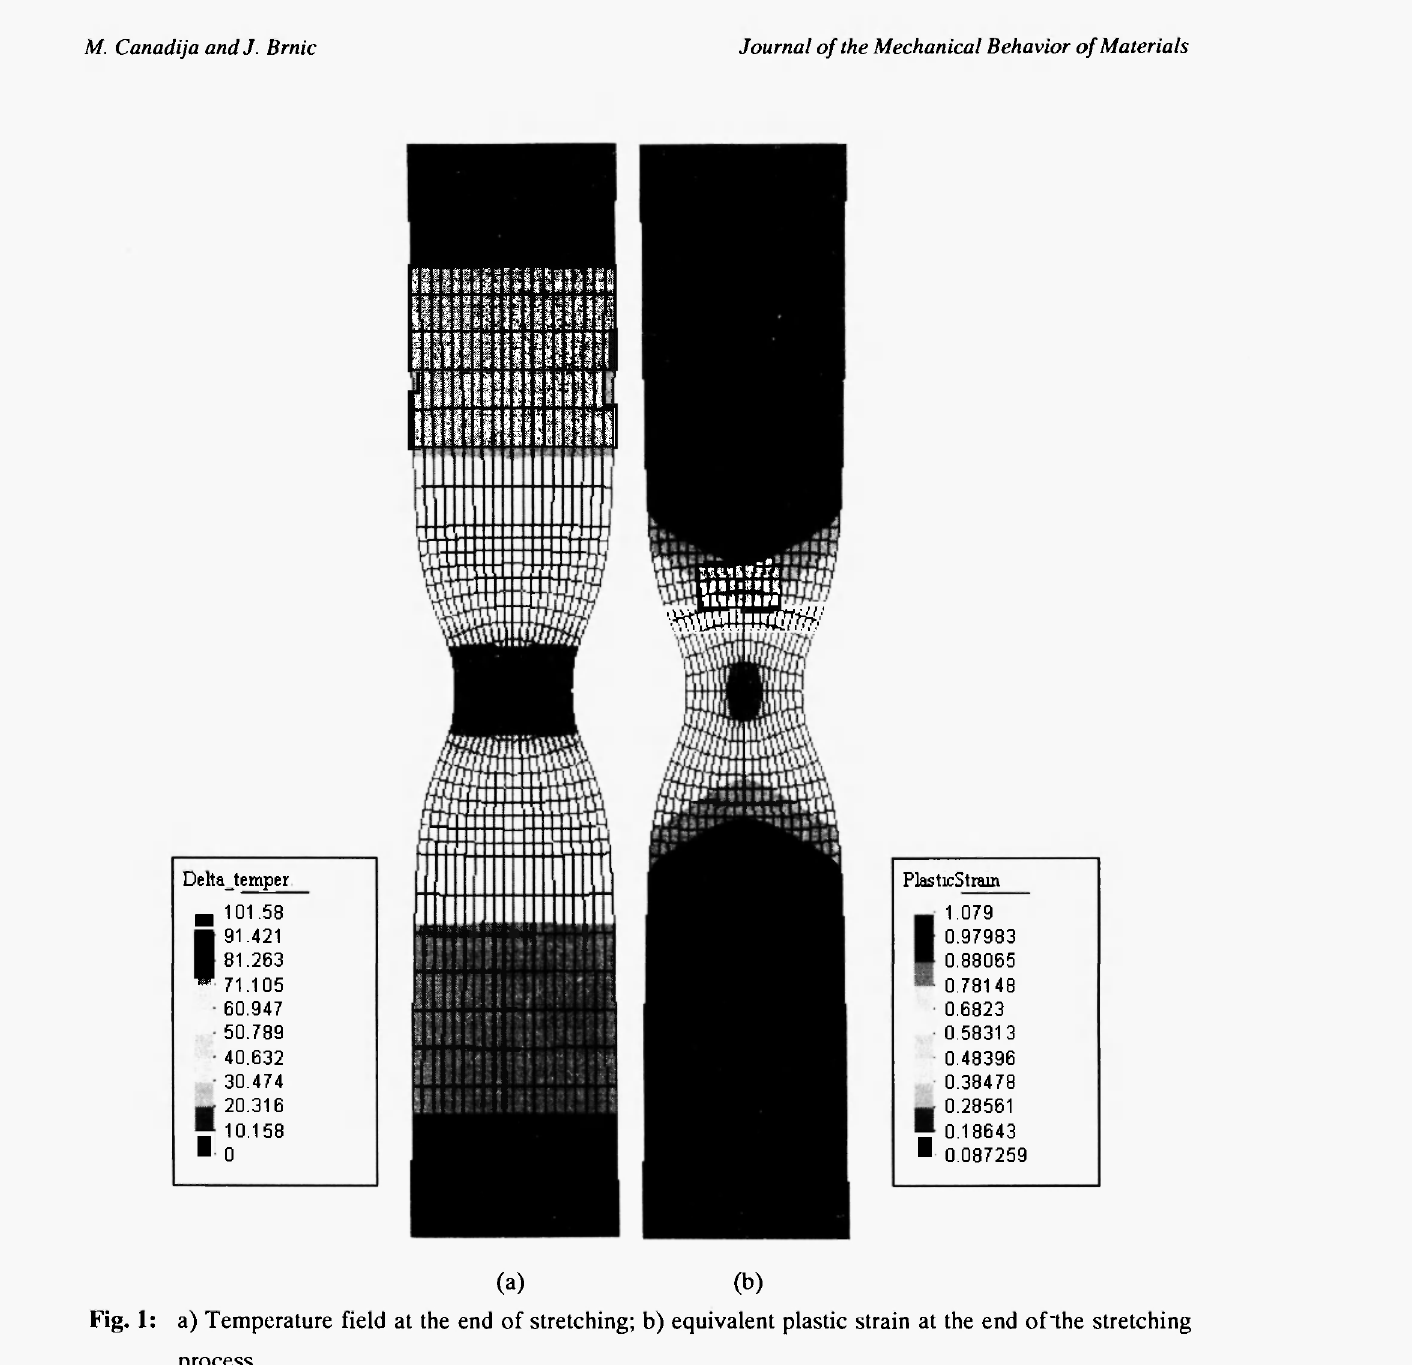
Fig. 1: a) Temperature field at the end of stretching; b) equivalent plastic strain at the end of "the stretching